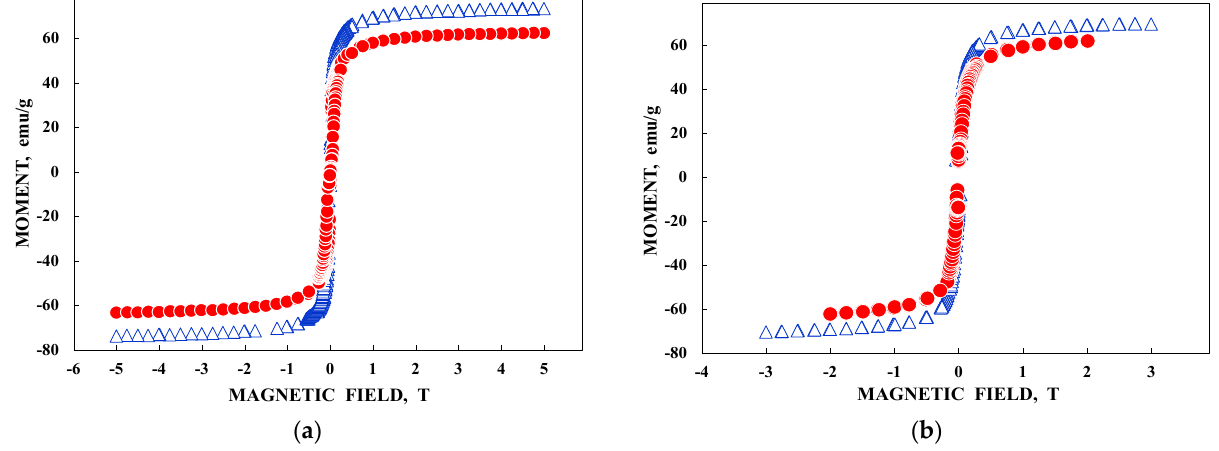
Figure 33. Scheme of the interaction between the as ‐ prepared magnetite nanoparticles and kau ‐ renoic acid (containing polar groups) after dispersion in Copaiba oil. Adapted from Ref. [72] with permission from Elsevier: Spectrochimica Acta, Part A: Molecular and Biomolecular Spectroscopy, Vol. 152, Oshtrakh M.I., Ushakov M.V., Šepelák V., Semionkin V.A., Morais P.C., “Study of iron oxide nanoparticles using Mössbauer spectroscopy with a high velocity resolution”, 666–679, ©2016.